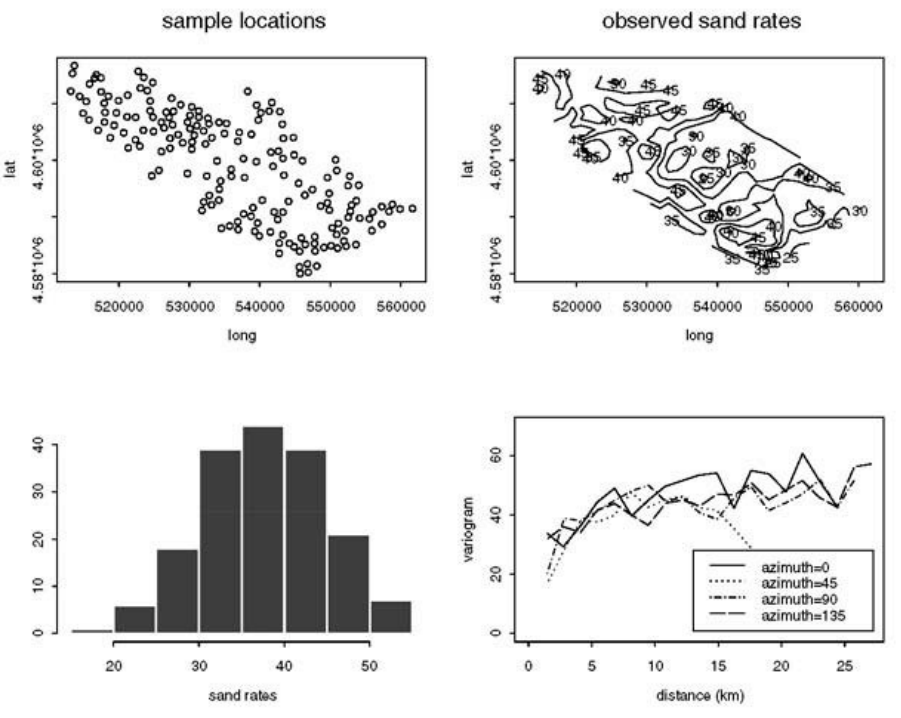
Figure 1 – Scatterplot of the 175 sampled locations, contourplot (based on a linear interpolation), histogram and directional variograms of the rates of composition in sand of the soil